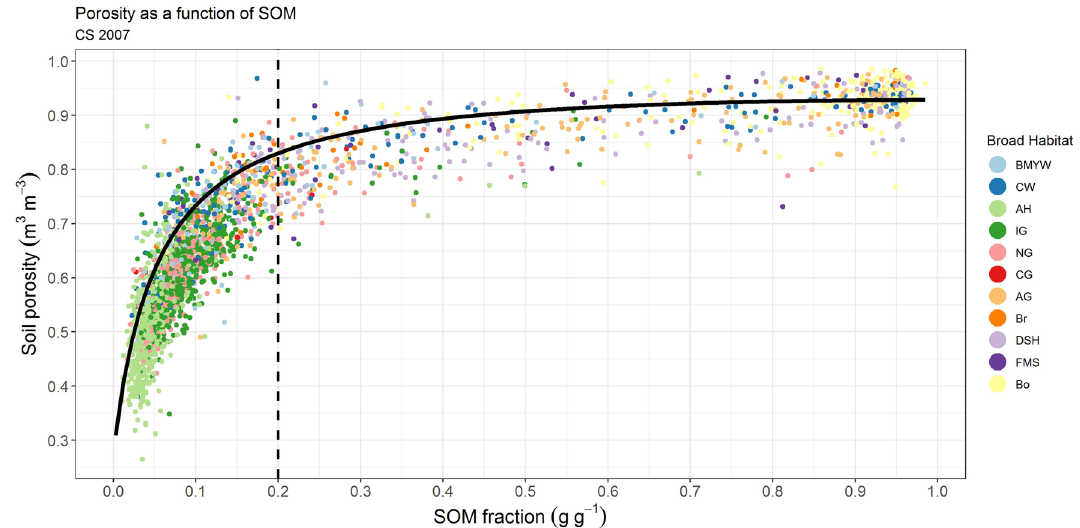
Figure 4. Soil porosity as a function of soil organic matter (SOM) content from the independent UKCEH Countryside Survey 2007 data set 36 n = 2570. The dashed line marks the transition from mineral soils (SOM < 0.2) to organic soils (SOM > 0.2). Markers are color coded by Broad Habitat, broad-leaved woodland (BMYW) coniferous woodland (CW), arable and horticultural (AH), improved (IG), neutral (NG), calcareous (CG) and acid (AG) grassland, bracken (Br), dwarf shrub heath (DSH), fen marsh swamp (FMS) and bog (Bo). The black line is the model (Eq. (7)) with CN = 9 and assuming intrinsic particle densities ρs OM = 1.4 g cm −3 GF OM = 117; z and ρs M = 2.7 g cm −3 and values for 2 √ 3 OM = 9 as used previously on the GMEP data; µ is × discounted.